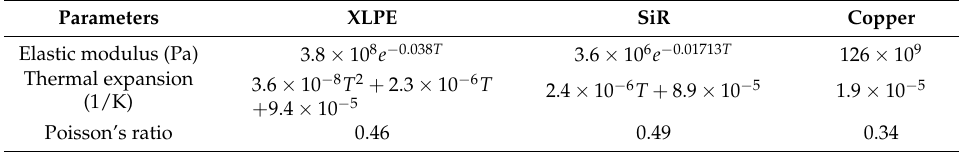
Figure 4. Overall process of thermal mechanical model for the cable joints. Table 2. Parameters used for the thermal mechanical stress model